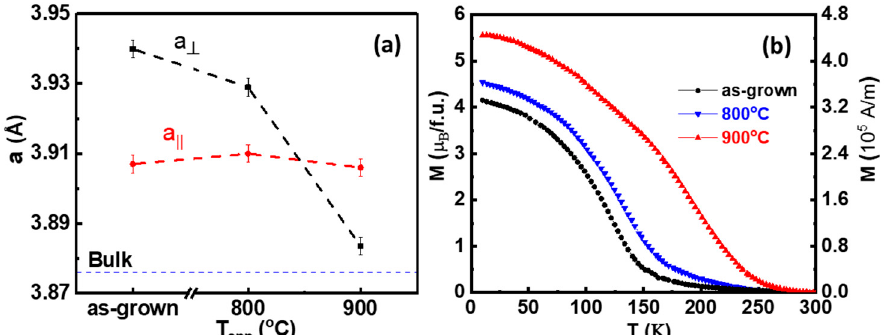
Figure 4. ( a ) Variation of in-plane (red dashed line) and out-of-plane (black dashed line) lattice parameters of LNMO film after different ex-situ annealing processes. The blue dashed line repre- sents the bulk counterpart value [23] and ( b ) corresponding temperature dependence of in-plane magnetization at µ 0 H = 0.5 T.